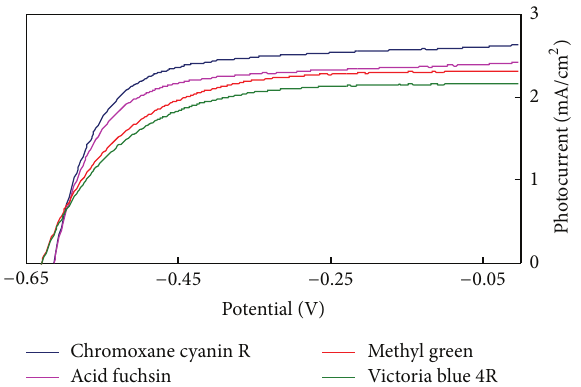
Figure 4: Photocurrent-voltage characteristics of TiO 2 electrodes sensitized with fluorone based dyes under illumination with 100mW/cm 2 light intensity.